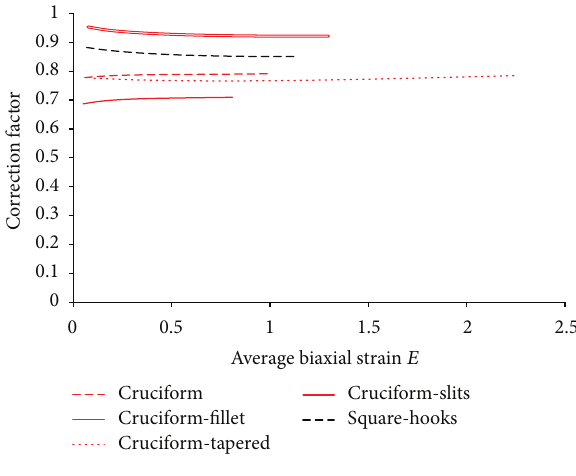
Figure 12: Stress correction